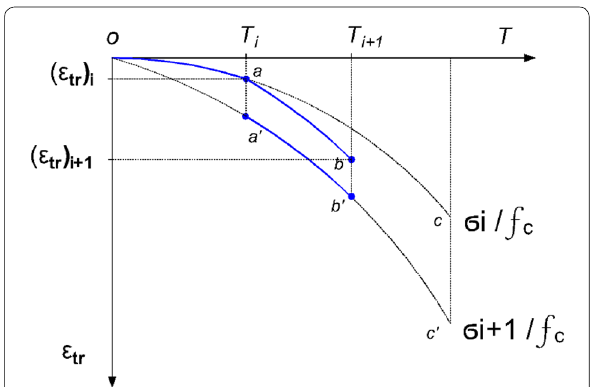
Fig. 16 Calculation scheme for TS under variable loading and rising temperature.